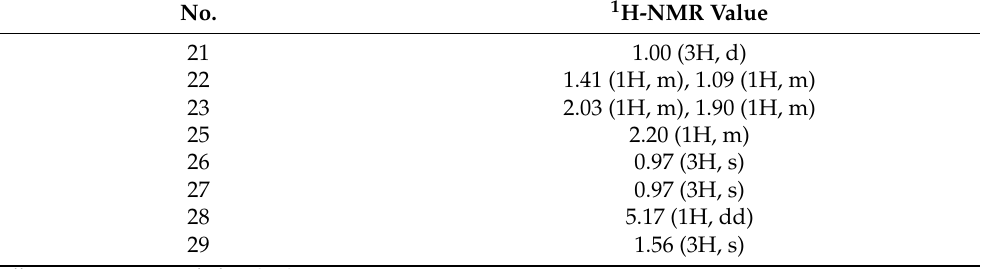
All spectra were recorded in CDCL 3 at 400 MHz.